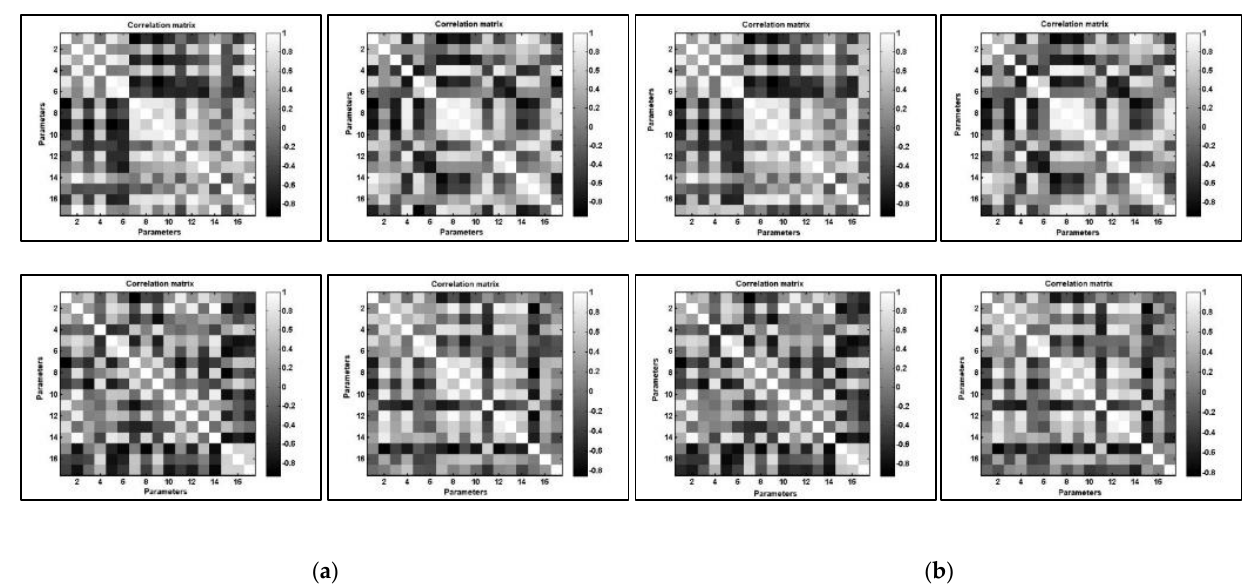
Figure 2. A tonal representation of the correlation matrices between the selected financial instruments and the ( a ) FTSE and ( b ) Dow Jones index.